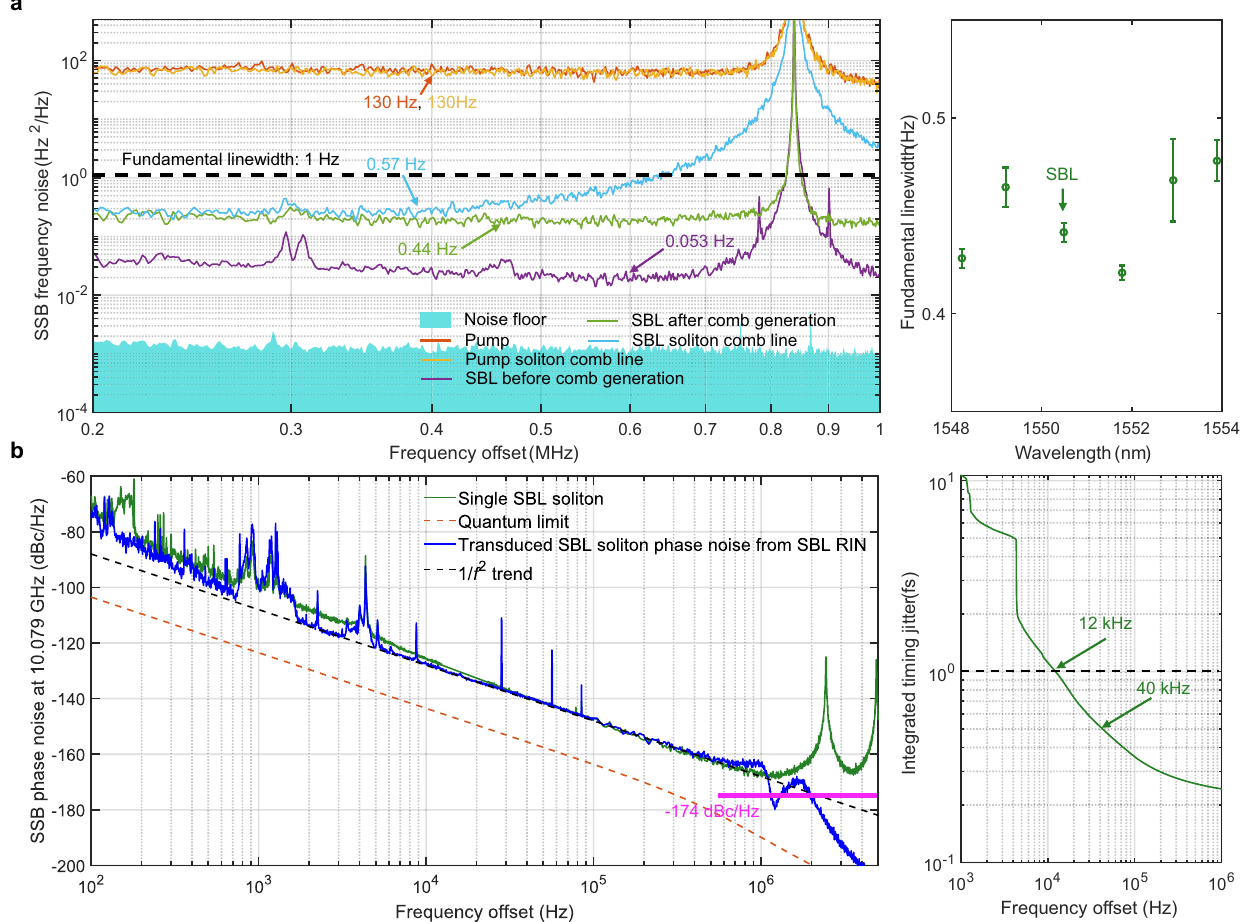
Fig. 4 | Fundamental linewidth and timing jitter of the SBL DKS microcomb. a SSB frequency noise spectra of pump and SBL DKSs (left), and the wavelength dependence of the SBL DKS microcomb line fundamental linewidth (right). Each linewidtherrorbaristheroot-mean-squareerrorcalculatedfrom8measurements. b SSB phase noise of the SBL DKS repetition rate, overlaid with the quantum noise